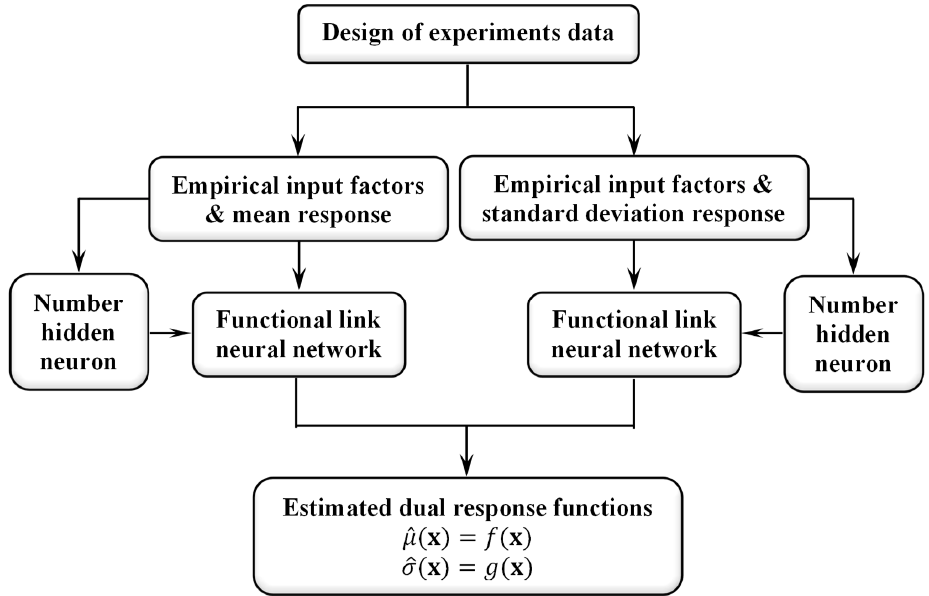
Figure 1. Proposed feed-forward NN-based estimation procedure.